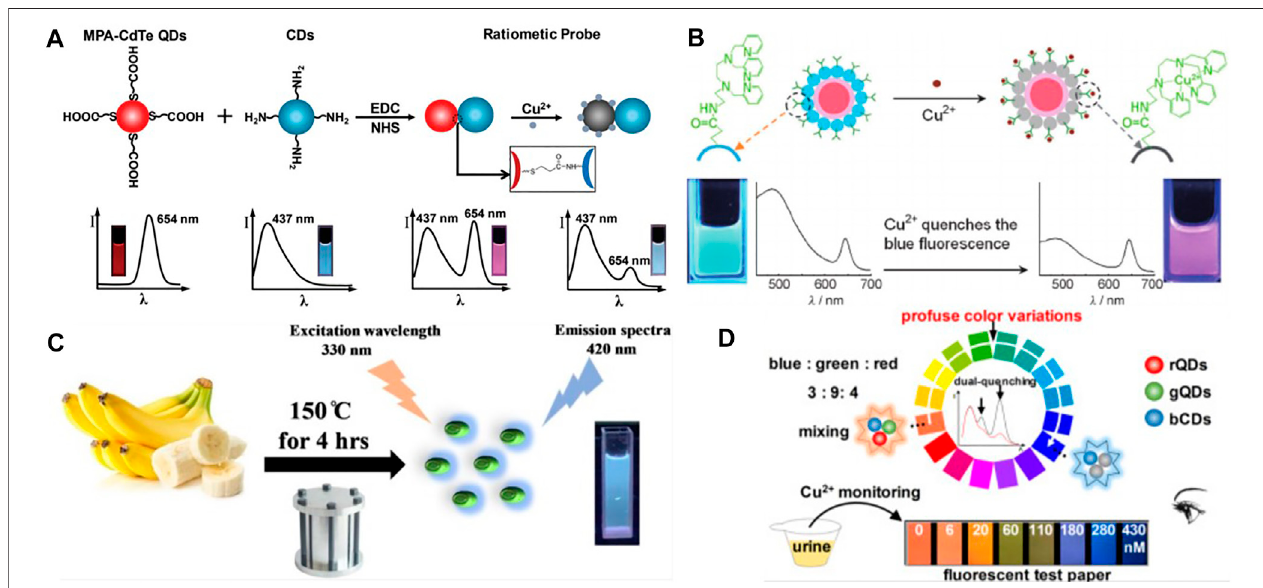
FIGURE 5| (A) Schematic illustration of the formation of the dual-emission ratiometric fl uorescence probe and the visual detection principlefor copper ions (Wang et al., 2016); (B) Dual-emission fl uorescent sensing of Cu 2+ ions based on a CdSe@C-TPEA nanohybrid (Zhu et al., 2012); (C) Schematic representation of NS-CQDs synthesis synthesizing NS-CQDs from banana juice (Chaudhary et al., 2020); (D) Schematic illustration of the visual detection principle for Cu 2+ using the tricolor probe (Cai et al., 2018).